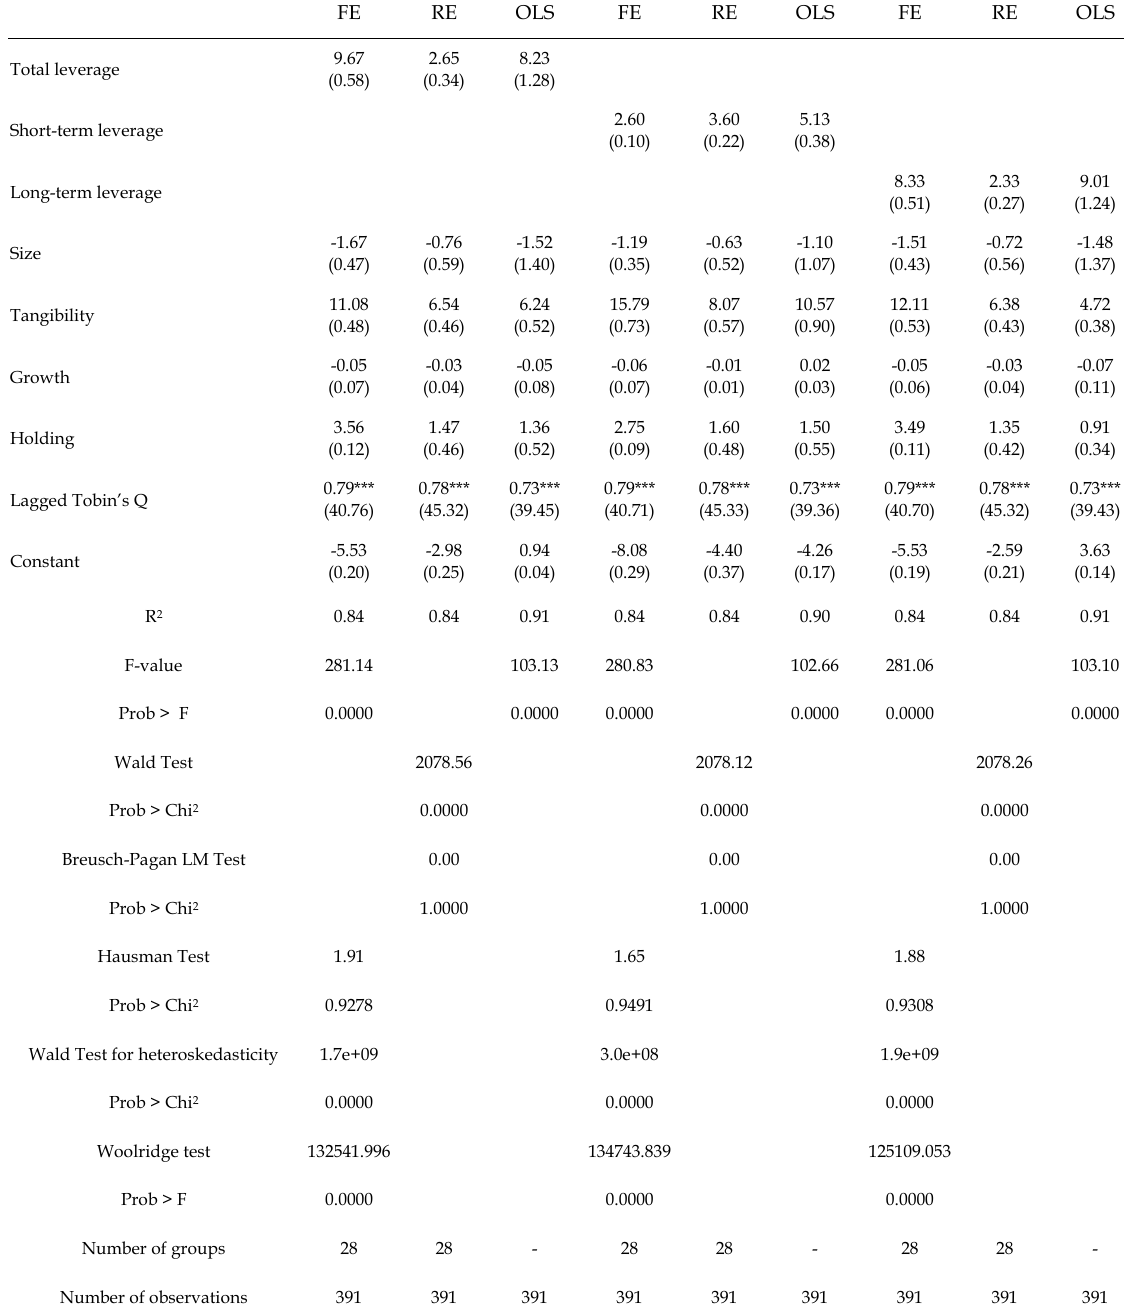
Table A2. Panel Data Estimation Results (Panel